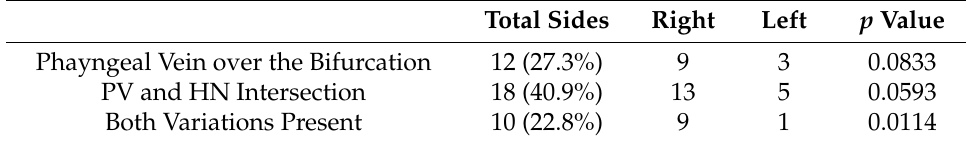
Table 2. Side lateralization